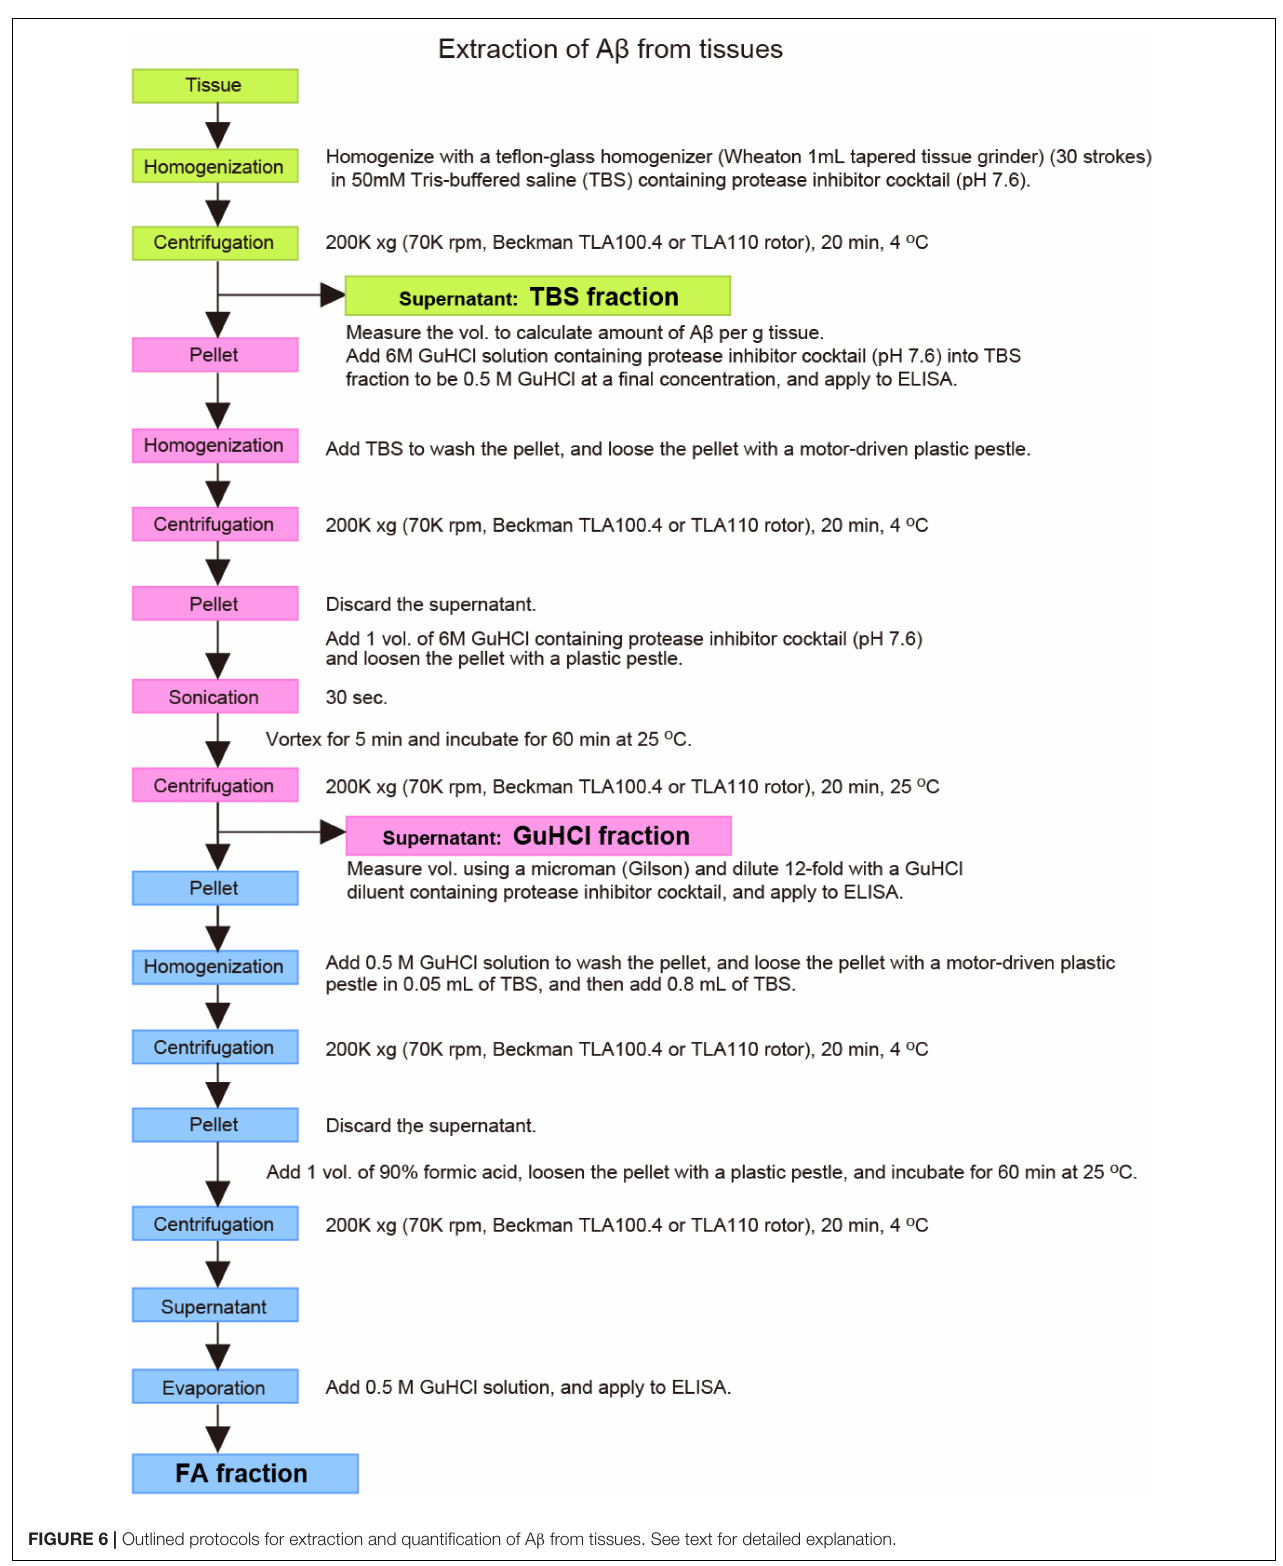
FIGURE 6 | Outlined protocols for extraction and quantification of A β from tissues. See text for detailed explanation.